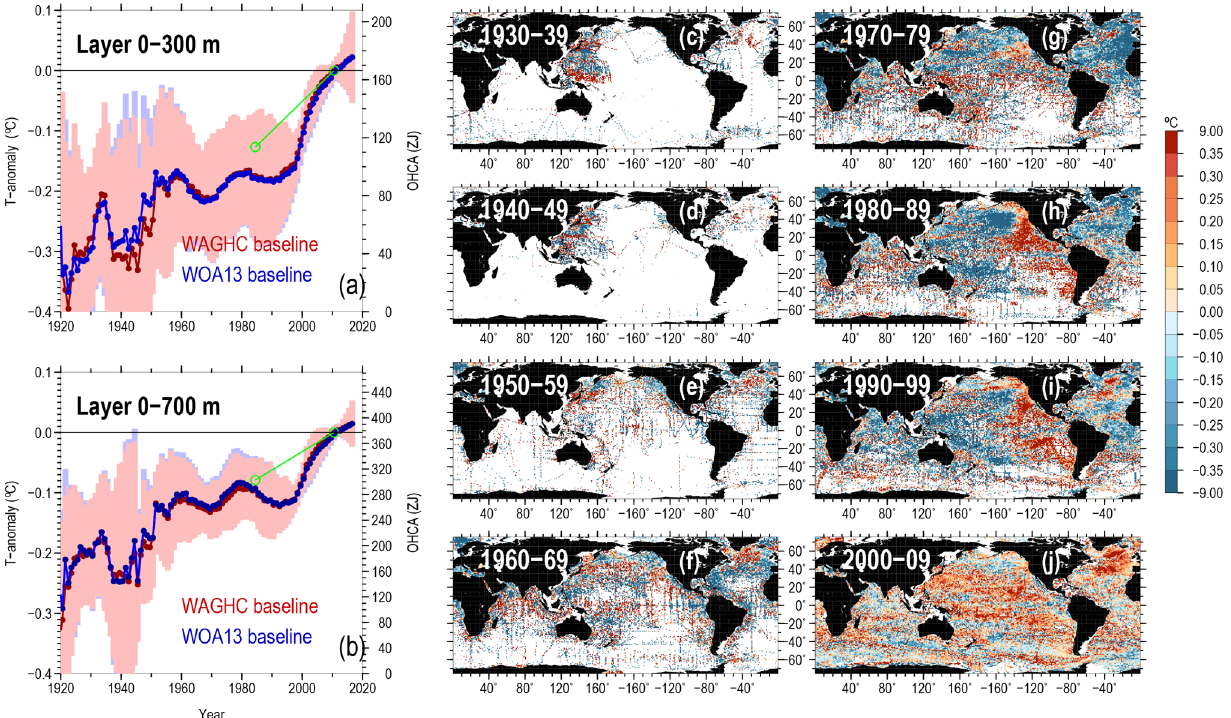
Figure 18. Decadal globally integrated ocean heat content anomaly (ZJ) time series for 1920–2016 for 0–300m (a) and 0–700m (b) layers computed using WAGHC (red curve) and WOA13 (blue curve) baseline climatologies. Error bars correspond to the errors due to the irreg- ular and incomplete sampling; the green line corresponds to the heat content change estimated by differencing the WAGHC and WOA13 climatologies. (c–j) The 0–300m layer temperature anomalies in 1 × 1 ◦ boxes averaged over the selected